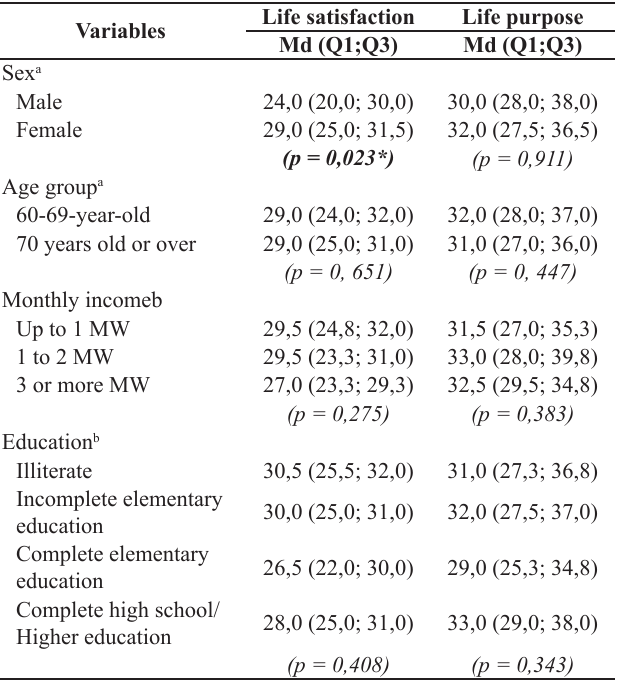
Table 3. Comparison between purpose in life and life satisfaction of the elderly who practice hydrogymnastics according to the sociode- mographic variables. Maringá, Paraná, Brazil, 2018.